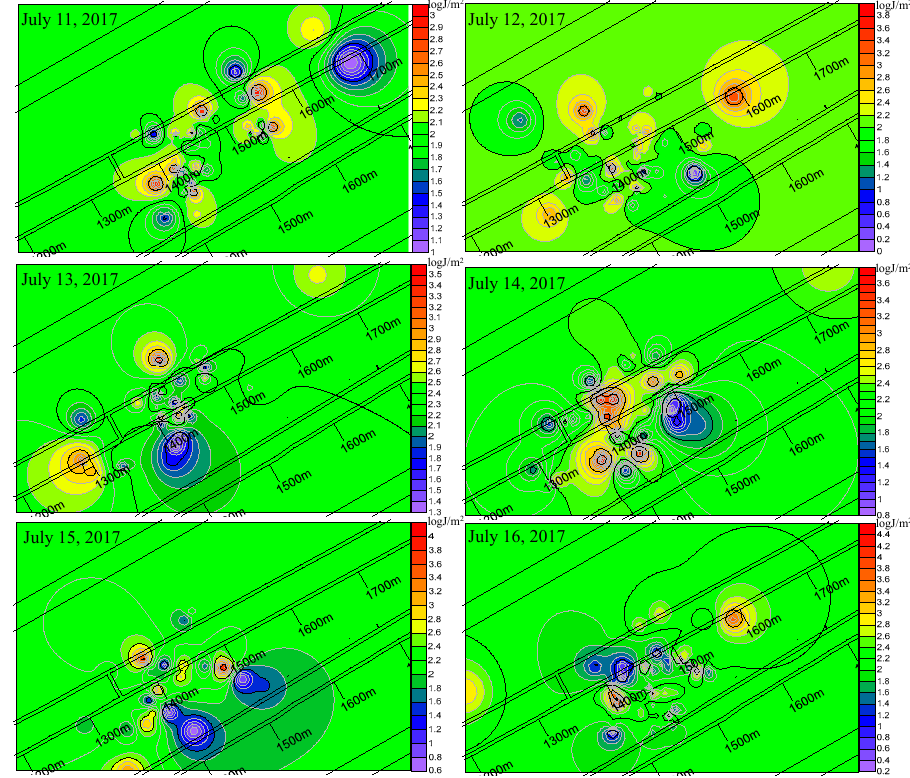
Figure 19. Spatial evolution law of the EDIM from 11 July 2017 to 16 July 2017. Stress-relief blasting was conceived as a type of rock weakening method that could reduce the stiffness and increase the deformation of the surrounding rocks to adjust the energy distribution state and to reduce stress concentration [53]. According to the spatial warning results, pressure relief measures of alternating shallow and deep boreholes were taken at corresponding areas. The parameters and layout of the blastholes are shown